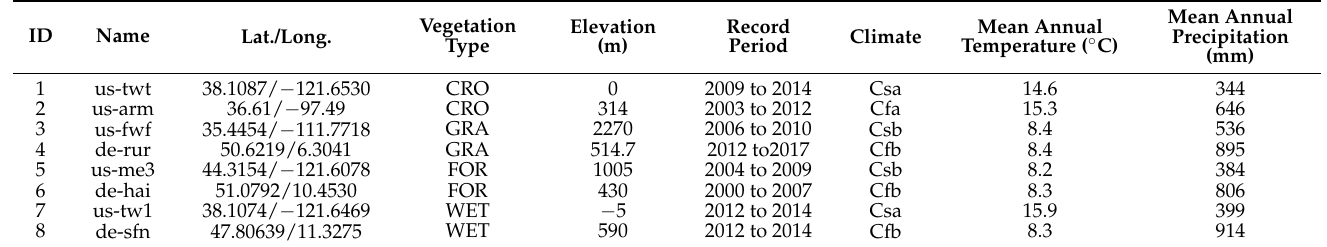
Table 3. Detail for the selected